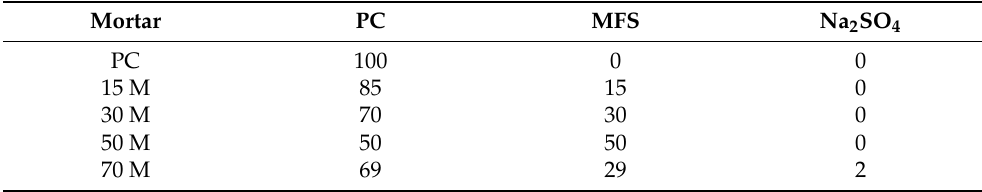
Table 2. Binder composition in wt.%. PC: Portland cement; MFS: Modified Ferro Silicate.